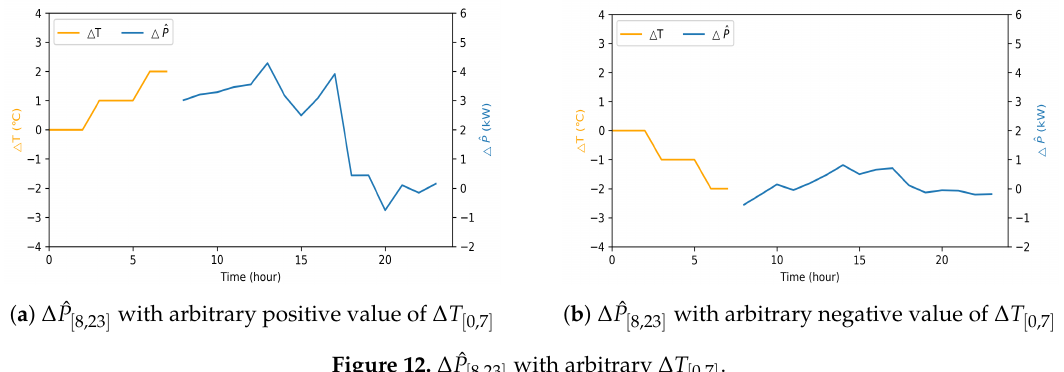
Figure 12. ∆ ˆ P [ 8,23 ] with arbitrary ∆ T [ 0,7 ] .